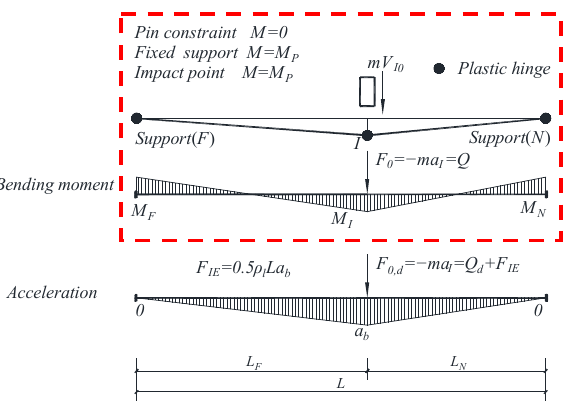
Figure 2. Typical design model .